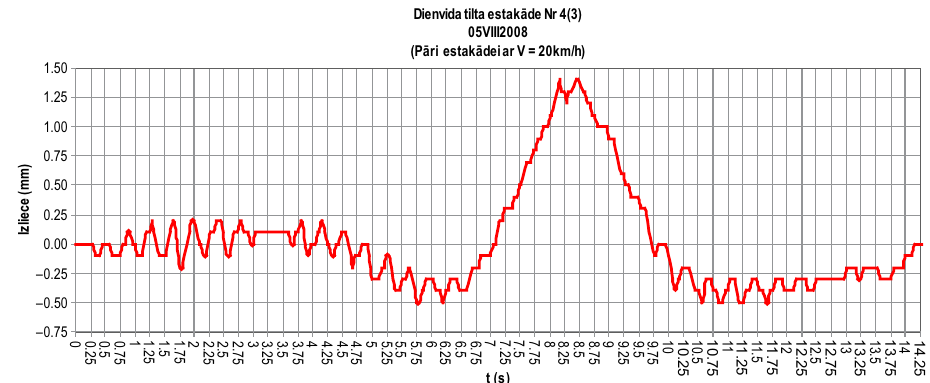
Fig. 2. The vibration response diagram obtained by the Noptel PSM-200 value should be applied to the worst static load case.